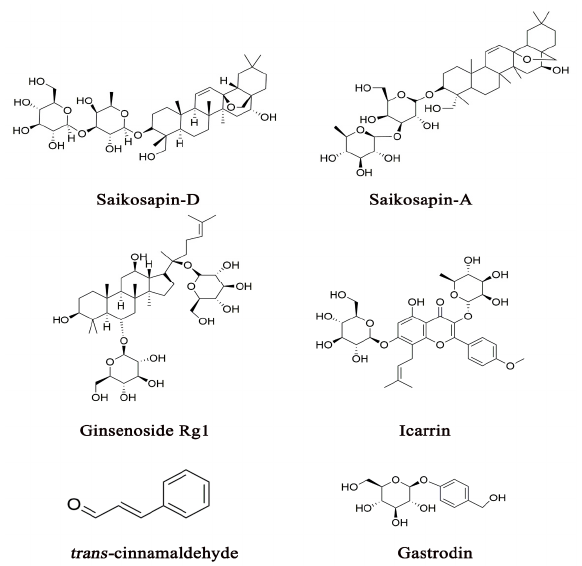
Figure 2. Several representative CHM constituents that have been demonstrated to exert antide- pressant activity, specifically by mediating the neuroimmune system. 3.1. Proinflammatory Cytokines and Cytokine Receptors Proinflammatory cytokines are mainly derived from immune cells such as mono- cytes, macrophages, lymphocytes, and dendritic cells, acting as important modulators of neuroinflammatory response [6]. Recently, several studies have investigated the influence of peripheral proinflammatory cytokines (e.g., IL-6, IL-1 β , and TNF- α ) on neuronal syn- aptic plasticity, neurogenesis, and neuromodulation, which play critical roles in the initi- ation, relapse, and progression of depression [47,48]. It is worth noting that these proin- flammatory cytokines are usually maintained at low levels under physiological conditions; however, its levels are increased by approximately 100-fold under stress-related patho- logical conditions [6]. In addition, microglia can release proinflammatory cytokines that influence the neurobiology of depression by decreasing the number and function of astro- cytes [19]. Furthermore, cytokine receptors have also been demonstrated to produce neu- robiological effects on microglia activation and neuroinflammation [19]. Bupleurum chinense DC has commonly been used to treat inflammation and infectious diseases [49]. Saikosaponin-D, a triterpenoid saponin isolated from Bupleurum chinense DC, has multiple pharmacological effects, such as anti-inflammation [50] and antidepressant activity [51]. A study has shown that pretreatment with saikosaponin-D (1 mg/kg, 7 days, i.g.) inhibited LPS-induced microglia activation and suppressed the secretion of proin- flammatory cytokines (IL-1 β , IL-6, and TNF- α ) [52]. Its mechanism of action has been sug-